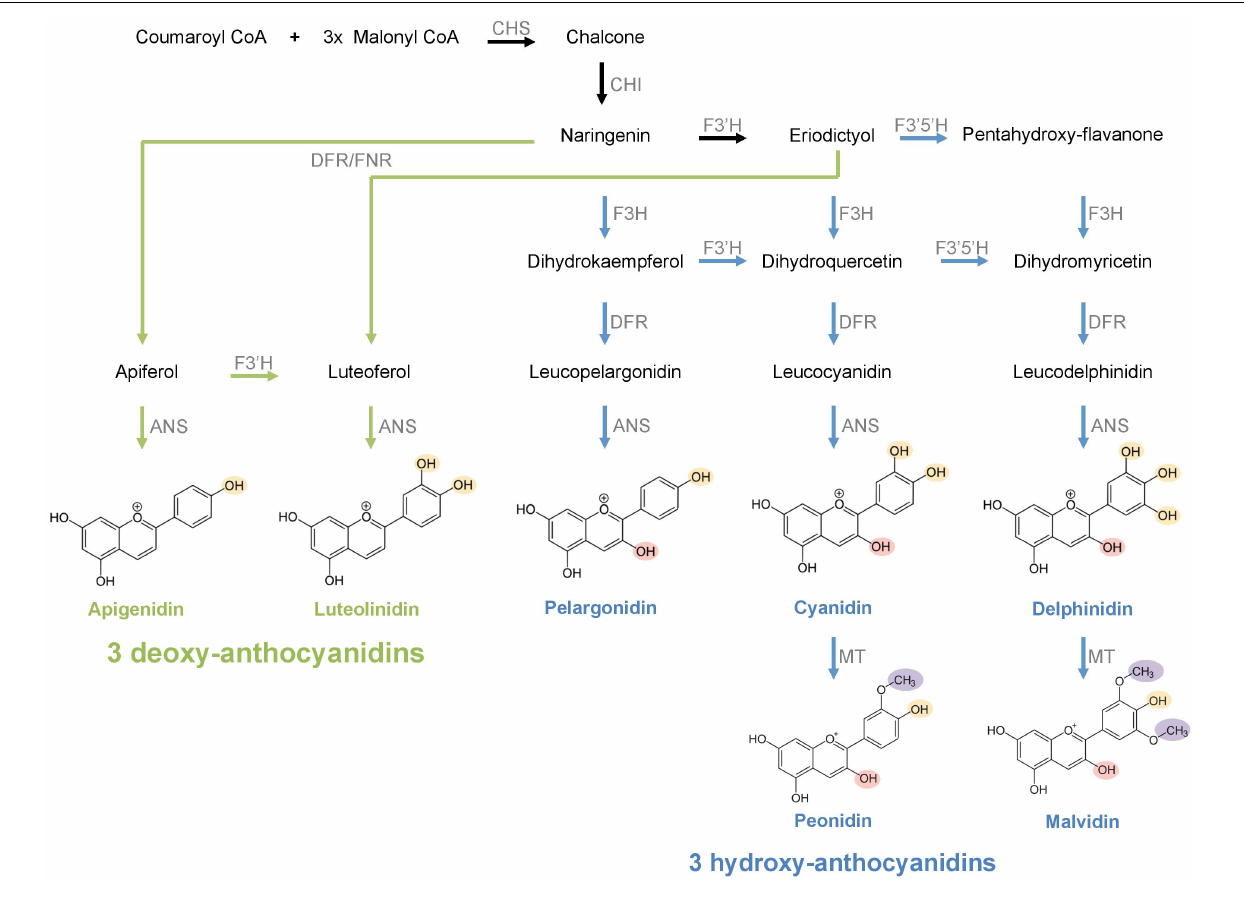
FIGURE 1 | The anthocyanin biosynthesis pathway. The reactions leading to hydroxy- and deoxy-anthocyanin compounds are represented in blue and green arrows, respectively. Earlier reactions preceding the two alternative pathways are represented in black arrows. OH groups differing between hydroxy- and deoxy-anthocyanins are colored in pink. OH groups in varying numbers in different anthocyanidins are colored in yellow. CH 3 groups in different hydroxy-anthocyanins are colored in purple. CHS, chalcone synthase; CHI, chalcone isomerase; F3 (cid:48) H, flavonoid 3 (cid:48) -hydroxylase; F3 (cid:48) 5 (cid:48) H, flavonoid 3 (cid:48) ,5 (cid:48) -hydroxylase; DFR, dihydroflavonol 4-reductase; FNR, flavone synthase; ANS, anthocyanidin synthase; MT,